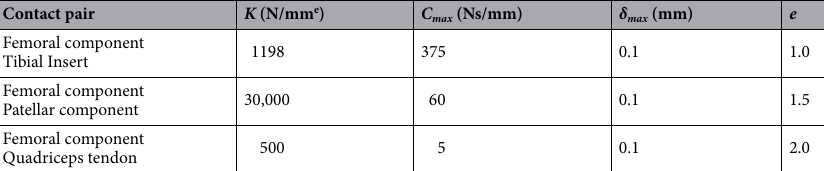
Table 3. Contact parameters. Value of contact stiffness ( K ), nonlinear power exponent ( e ), maximum damping constant (C max ), maximum penetration constant (δ max ) for the different contact